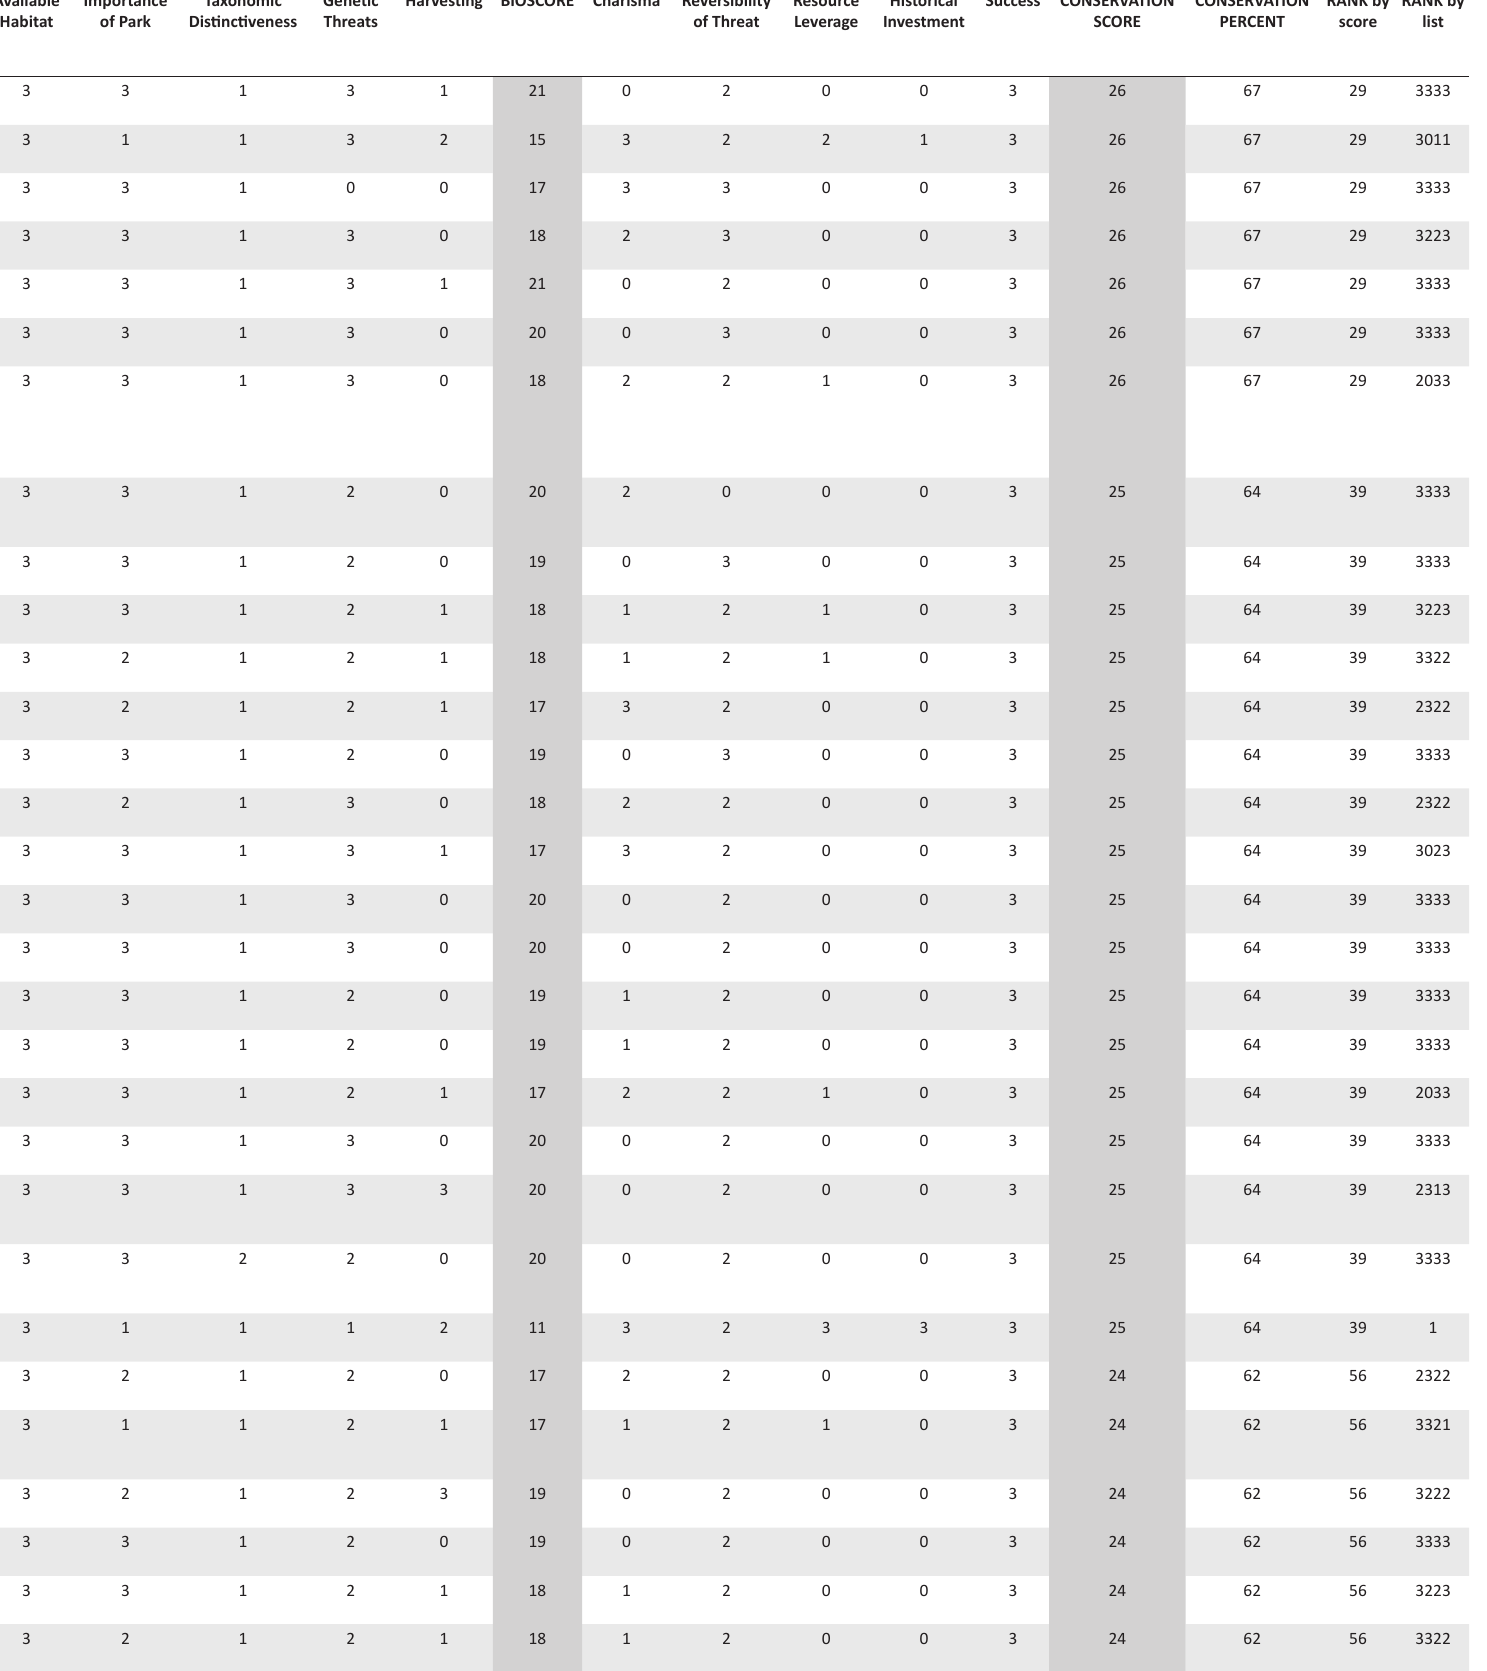
Online Appendix Table 1 (Continues...): List of species of Special Concern in the Table Mountain National Park and associated scores